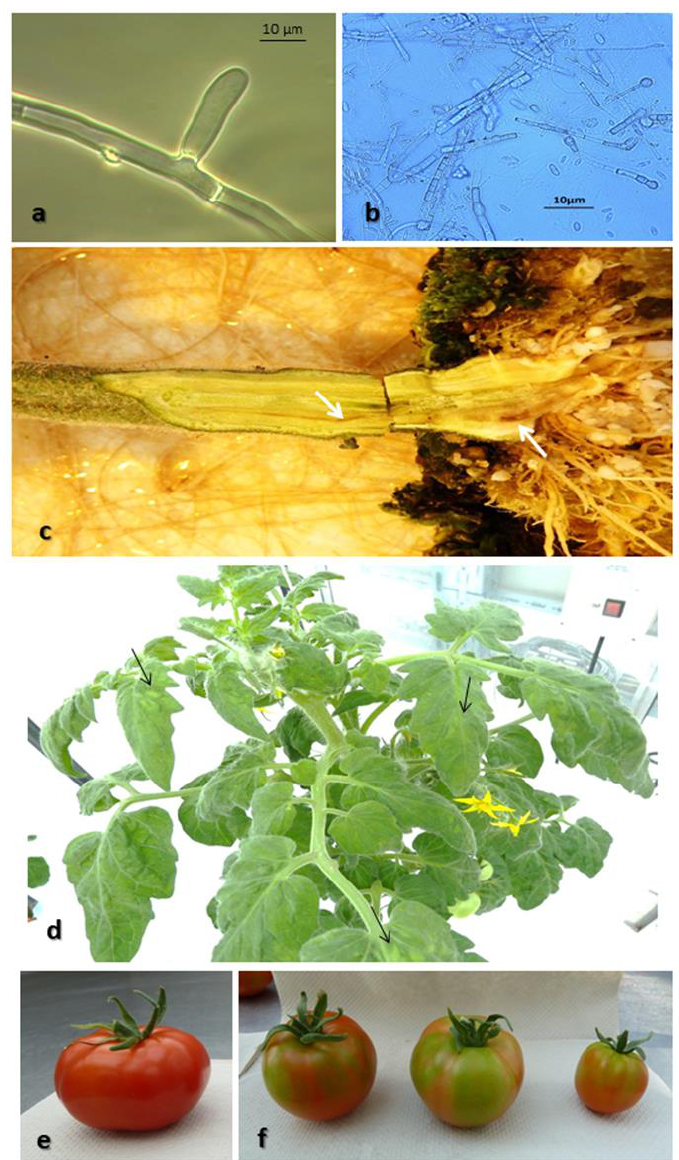
Figure 3. Fungal and viral pathogens causing characteristic symptoms in tomato plants. ( a ) R. solani mycelium; ( b ) F. oxysporum chlamydospores, macroconidia and microconidia; ( c ) vascular discoloration by F. oxysporum (white arrows) and root rot by R. solani ; ( d ) TMV-induced mottling, curling (black arrows) and stunting leaves; ( e ) fruit of a healthy tomato plant; ( f ) PepMV-induced discoloration of fruits and reduction of tomato size.